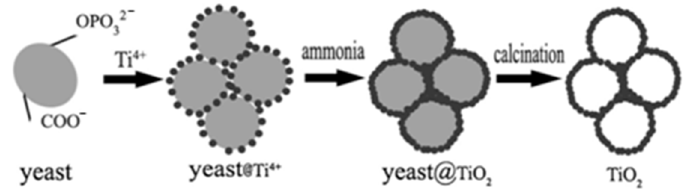
Figure 9. Schematic illustration of the formation of porous TiO 2 . Reprinted with permission from [38].